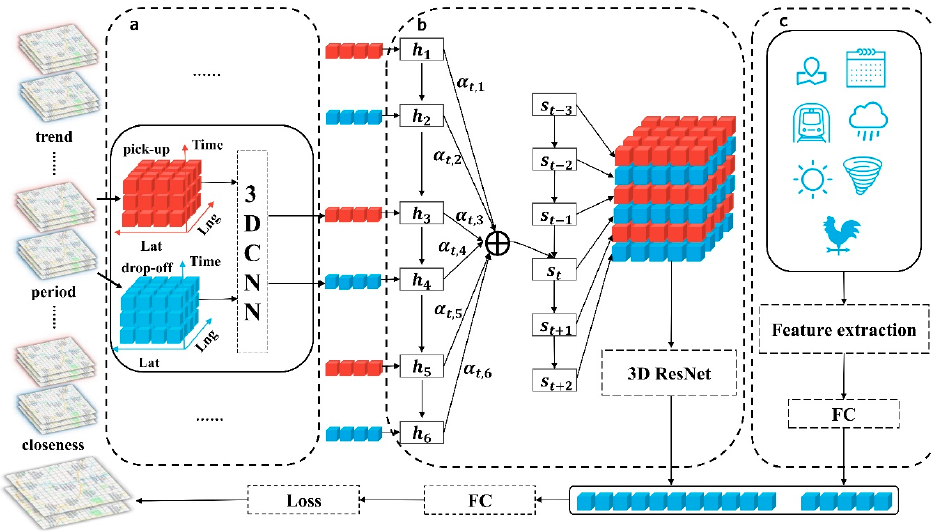
Figure 2. Architecture of the proposed model Figure 2 . Architecture of the proposed model Taxi3D.